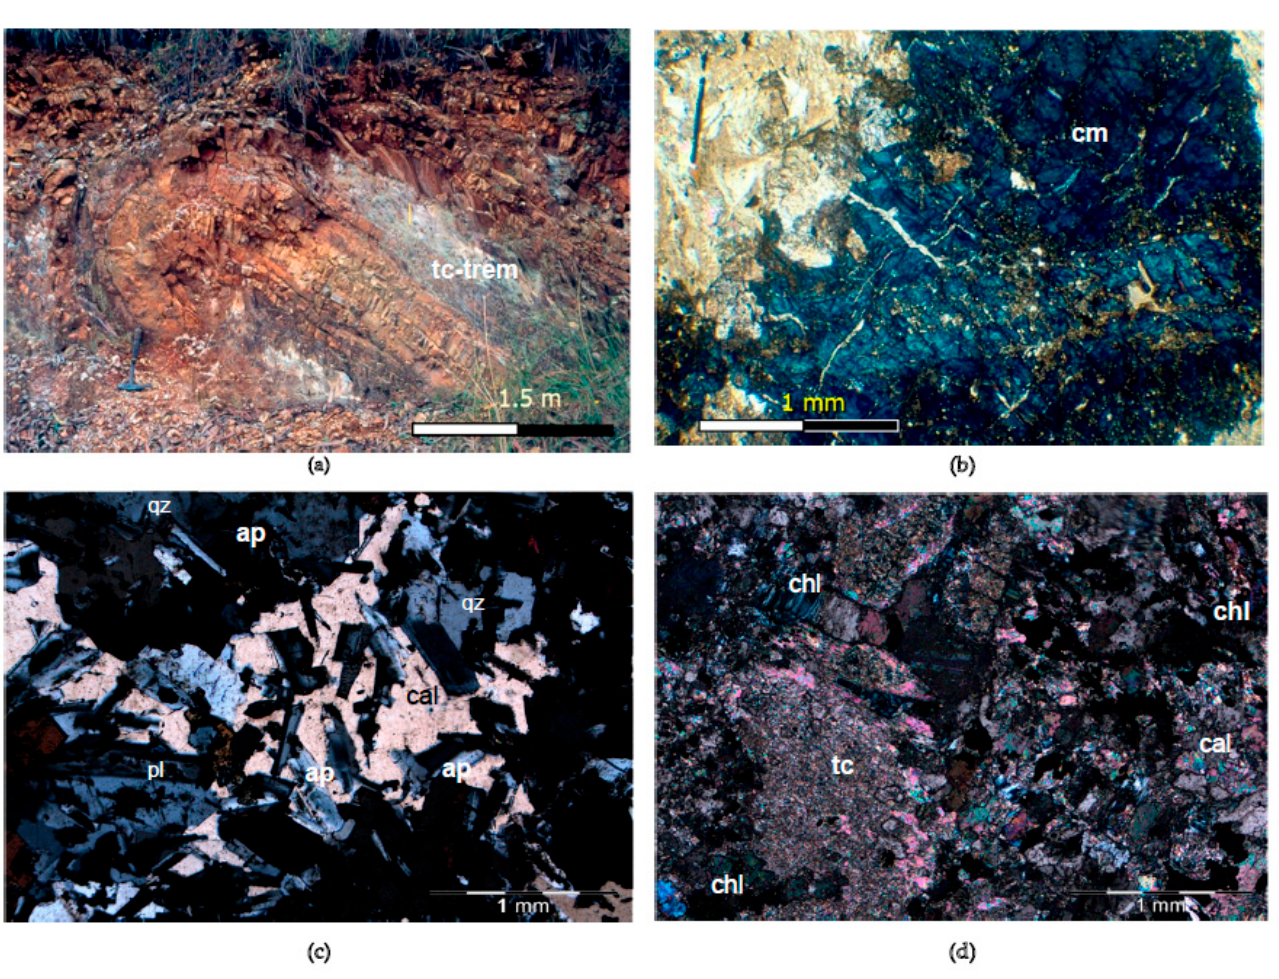
Figure A1. Plate 1. Country rocks and lower intrusive units: ( a ) Talc-tremolith-rich (tc-trem) layers in chert-rich dolomite (Oak Tree Formation, Malmani Subgroup) on farm Uitkomst; ( b ) Micropho- tograph (MP) (crossed polarisors, XPL) of cm-sized Corundum (cm) porphyroblasts in meta-pelite contact aureole (max. 30 m width); ( c ) MP (XPL) of Basal Gabbro: Interstitial calcite (cal), quartz (qz), plagioclase (pl) and apatite (ap); ( d ) MP (XPL) of Lower Pyroxenite: Talc (tc)-carbonate-amphibole- chlorite (chl) alteration.